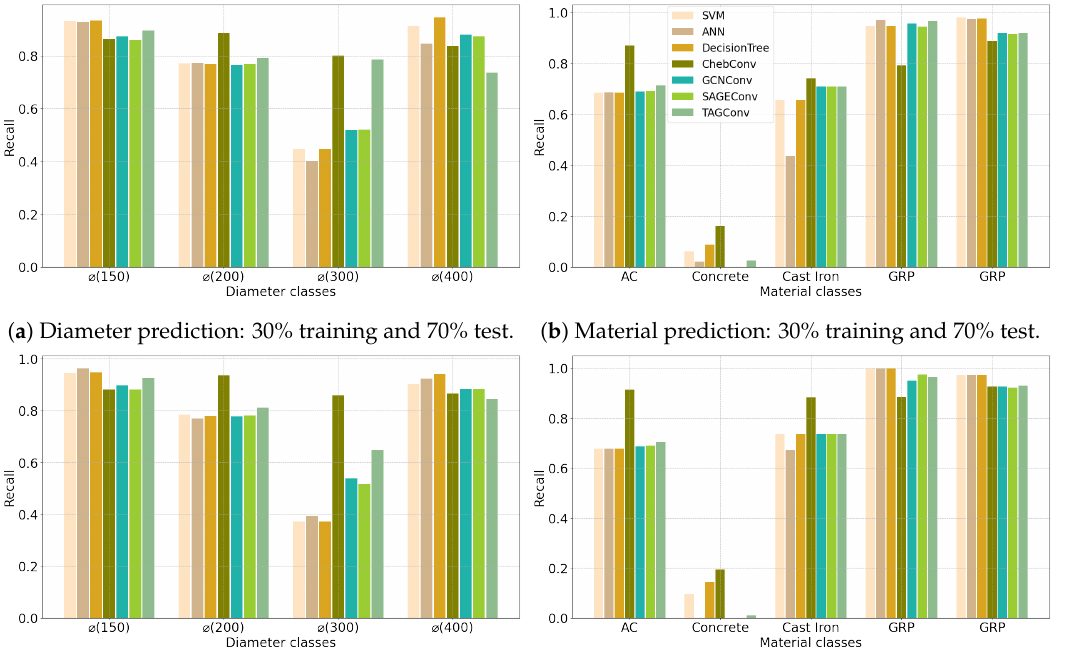
Figure 8. Configuration 2: Diameter and Material prediction for the Montpellier dataset for each class of the two attributes, evaluated using Recall